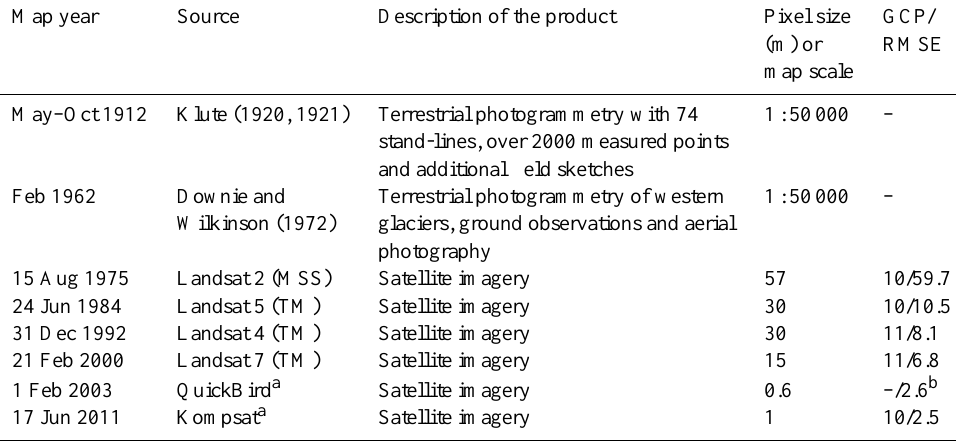
Table 1. Details of the terrestrial photogrammetry and satellite products used to characterize the retreat of the glaciers on Kibo. The spatial resolution is given as either a map scale or pixel size. The number of ground check points (GCPs) used for image matching and the root mean square error (RMSE) (m) associated with the orthorectification (m) are also provided. Two further Landsat images and one ASTER image were also processed but are not listed as they were not formally used for the time series (see Sect. 2.2). Map year Source Description of the product Pixel size GCP/ (m) or RMSE map